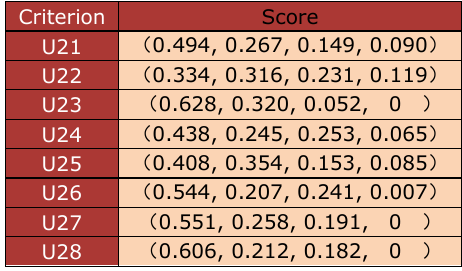
Table 6. Criteria scores of